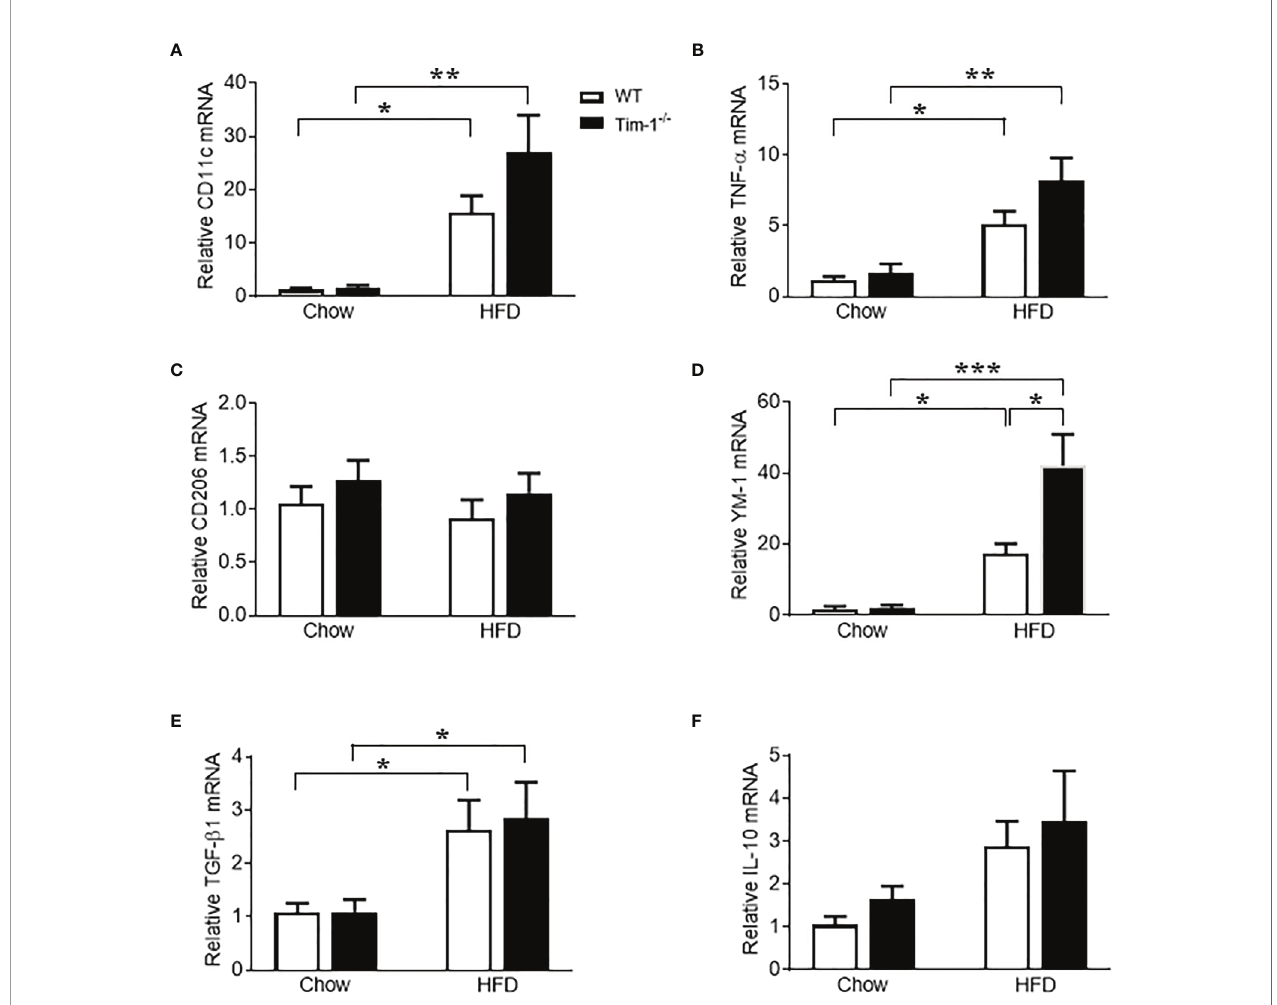
FIGURE 8 | Effects of Tim-1 de fi ciency on M1 and M2 macrophages. Real-time PCR analysis of hepatic gene expression of M1 macrophage marker CD11c (A) , proin fl ammatory cytokine TNF- a (B) , M2 markers CD206 (C) and YM-1 (D) , and anti-in fl ammatory cytokine TGF- b 1 (E) and IL-10 (F) . Values are mean ± SEM. n=4- 6 mice. Statistical differences were assessed by one-way ANOVA with Tukey ’ s multiple comparisons test; * P <0.05, ** P <0.01, *** P